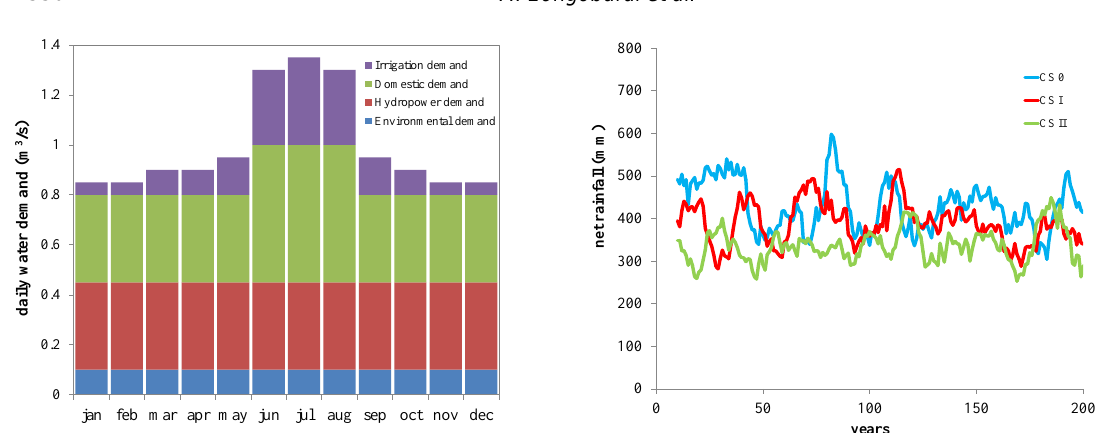
Fig. 4 Daily water demand, on a monthly base, divided by irrigation, domestic, hydropower and environmental consumptions (left panel) and 10-years moving average for net rainfall (right panel)